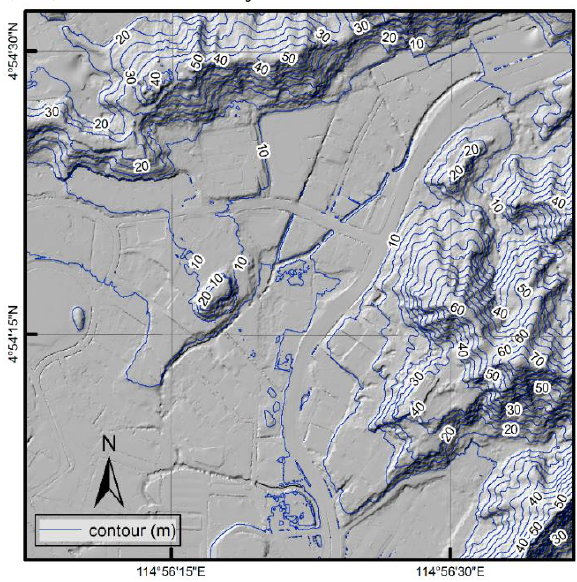
Figure 1. Hillshadow DTM of the AOI